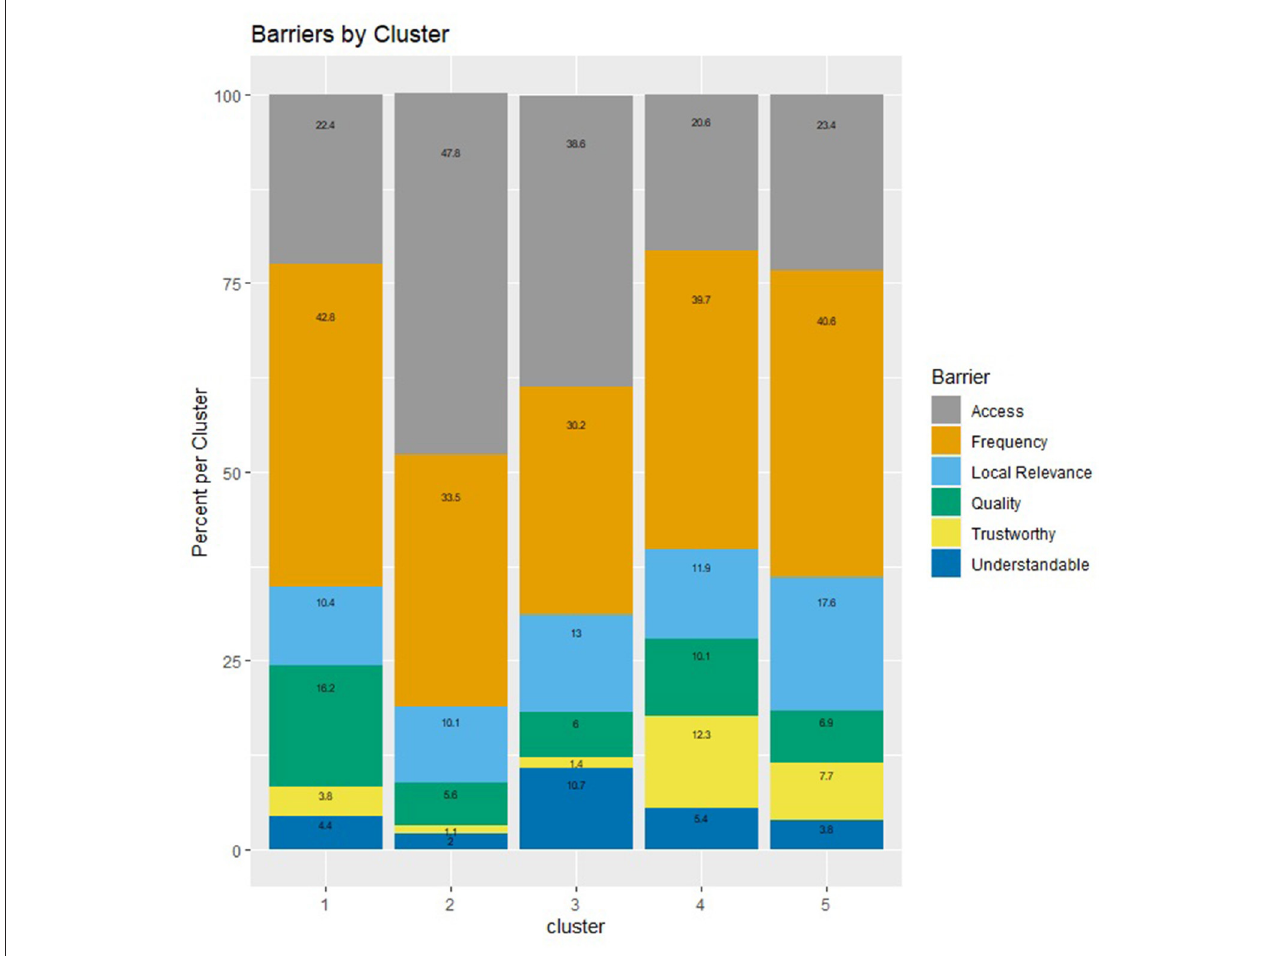
FIGURE 4 | Distribution of perceived barriers to accessing and using climate information by cluster. Values are percentages of the barriers within the cluster.